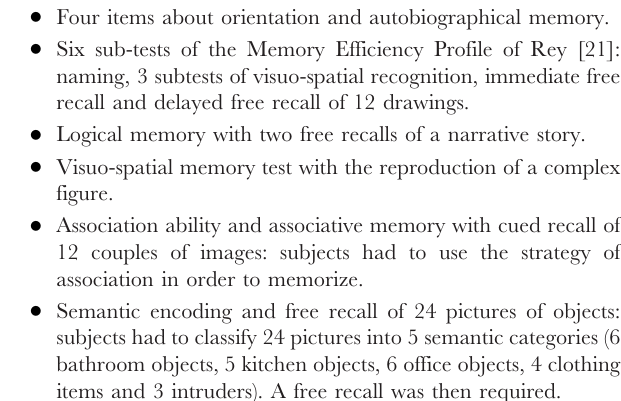
figure. N Association ability and associative memory with cued recall of 12 couples of images: subjects had to use the strategy of association in order to memorize.